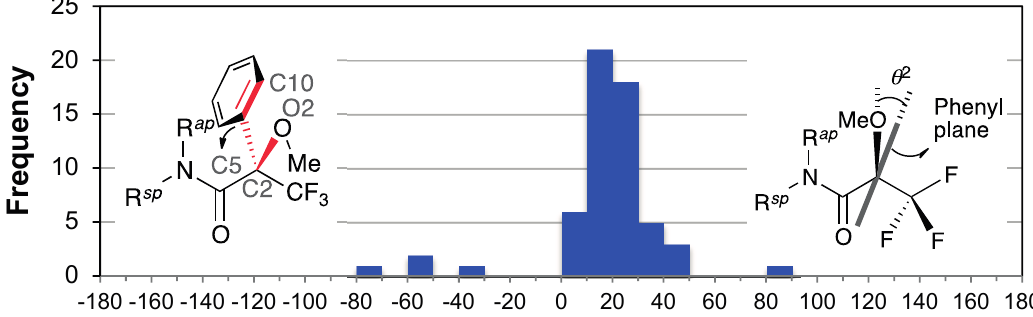
Figure 9. Histogram for dihedral angles O2–C2–C5–C10 ( θ 2 ) of all MTPA amides. C10 is